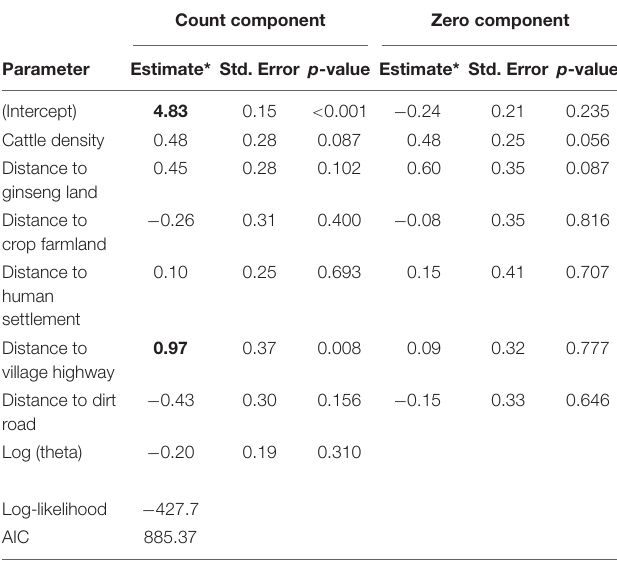
*Bold text indicates statistical significance (p <